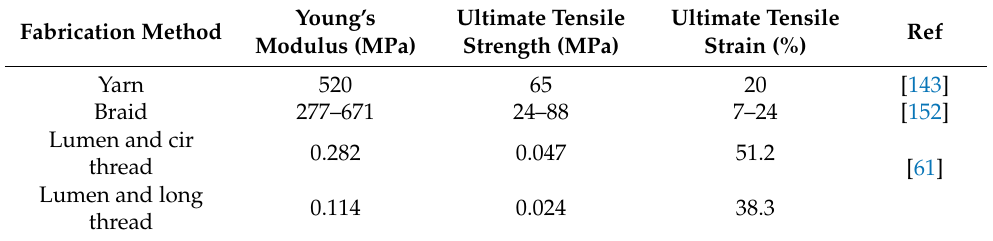
Table 6. Summary of the mechanical properties of post-electro-compaction fabrication methods.